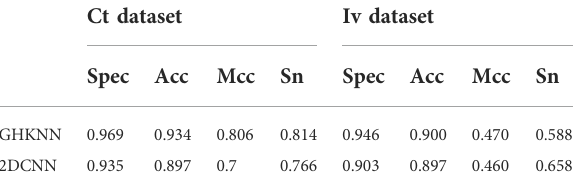
TABLE 4 Values of Sn, Acc, Spec, and Mcc of the GHKNN and 2DCNN classi fi ers on the Iv dataset and Ct dataset.